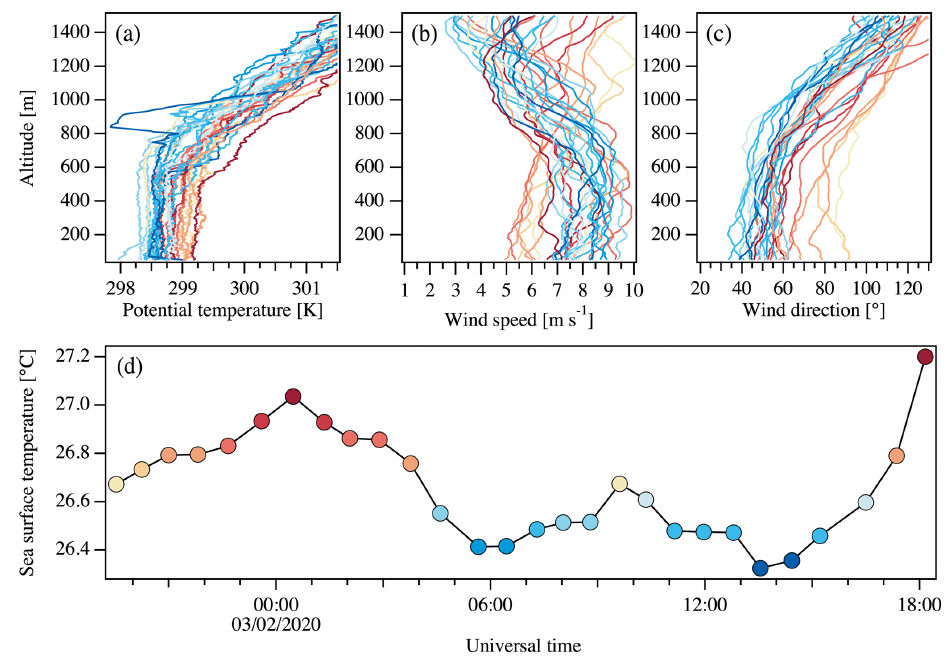
Figure A2. Vertical profiles (50–1500m) from Meteomodem M10 sondes launched during the second targeted intensive radiosonde period (Fig. A1b) for (a) potential temperature and horizontal wind (b) speed and (c) direction, and (d) the corresponding SST time series from the Atalante TSG, with each circle corresponding to a Meteomodem launch. Colors are indicative of the SST ( ◦ C) at the time of each launch. Vertical profiles are built from Level 0 raw measurements. Date format: